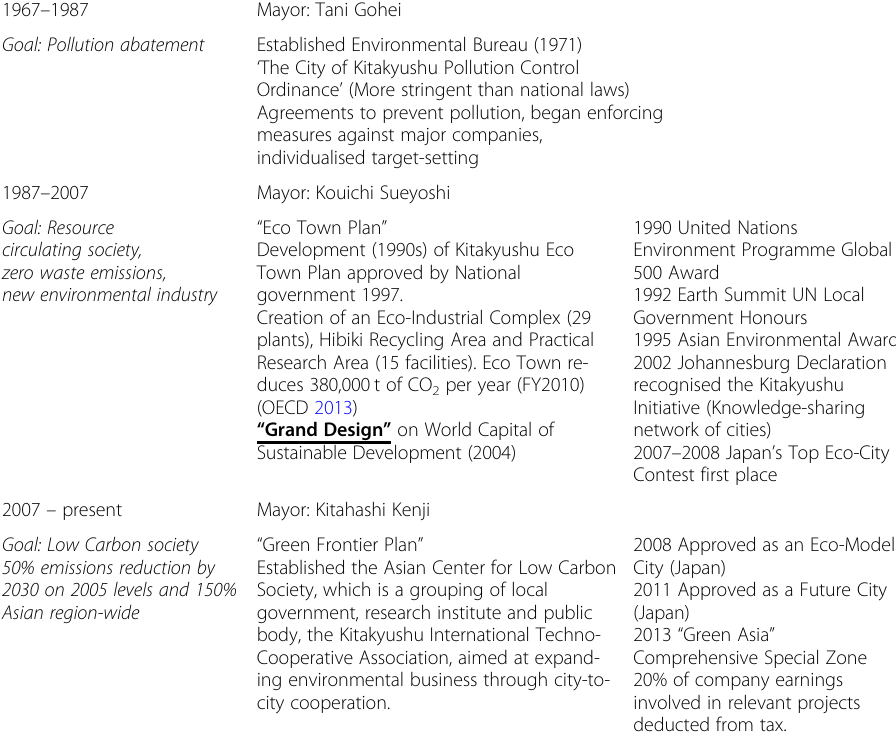
Table 3 Policy overview and environmental